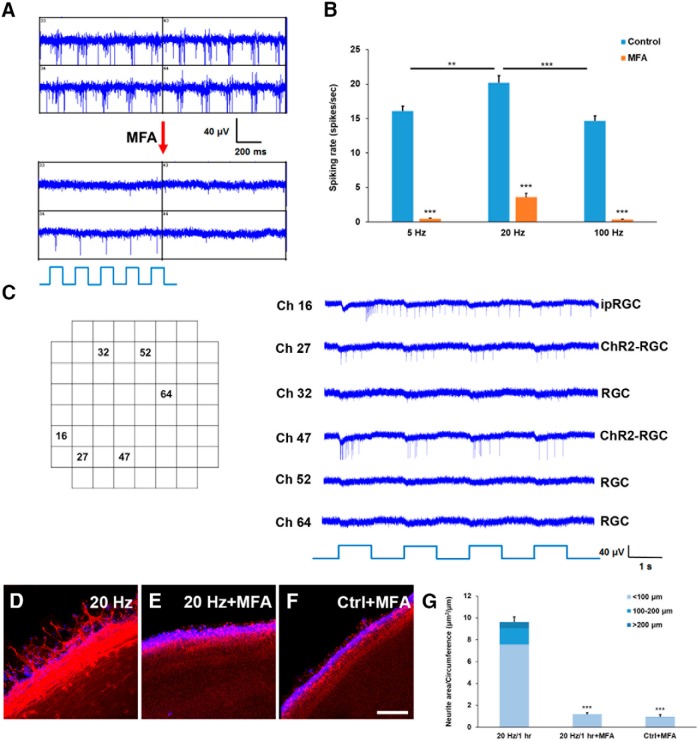
Blocking the gap junctions in the explant retinas significantly reduces the response strength and number of blue light evoked RGCs from P11 retinas of ChR2 mice. A, MEA recording of four neighbor channels showing the responses of RGCs on 5 Hz blue light stimulation. All channels showed strong spiking responses before the addition of MFA (100 μM) to block the gap junctions. After blocking gap junction activity, the light responses of all channels were decreased drastically, and only one channel showed a reliable spiking response on each blue light stimulation. B, Application of MFA significantly decreased the spiking rates of RGCs in response to 5, 20, and 100 Hz blue light stimulation (n = 52 for each condition). C, An MEA recording showing a representative RGC responses on multiple 1-s blue light stimulations. After blocking the retina’s gap junctions, most channels showed no light response (only #32, #52, and #64 are shown here). However, a few channels did show a reduced yet reliable response on each blue light stimulation (and #47), and these are likely to be ChR2-expressed RGCs. Occasionally, one or two channels showed a long-lasting response to blue light stimulation, which suggests that these are one of ipRGCs present in the developing retina. D–F, Confocal images of P11 ChR2 retinal explants at DIV 5 with 20 Hz light stimulation for 1 h, 20 Hz light stimulation for 1 h with 100 μM MFA, and no light stimulation with 100 μM MFA, respectively. All morphologically recognized neurites were TUJ1-positive (red), and DAPI was used to label nuclei (blue). Scale bar, 100 μm. G, MFA application which blocks gap junction coupling significantly reduced neurite outgrowth of P11 ChR2 retinal explants, even under 20 Hz light stimulation for 1 h (n = 9 for 20 Hz; n = 5 for 20 Hz with MFA; n = 3 for the control with MFA); **p < 0.01, ***p < 0.001. Error bars, mean ± SEM.